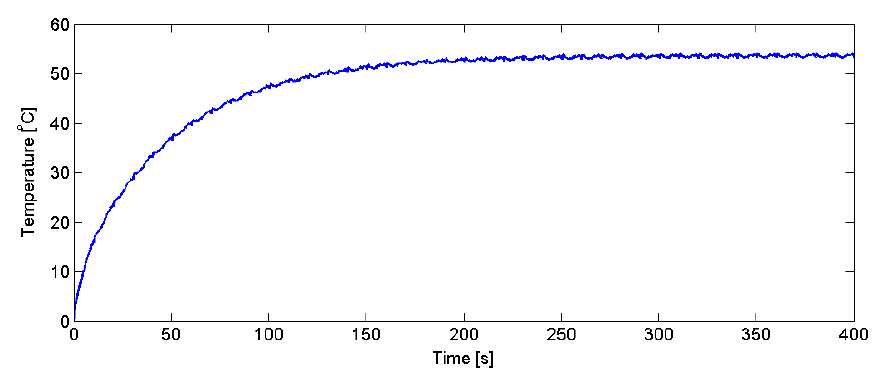
Figure 13. Transient temperature of the AFSRM winding calculated using a thermal equivalent